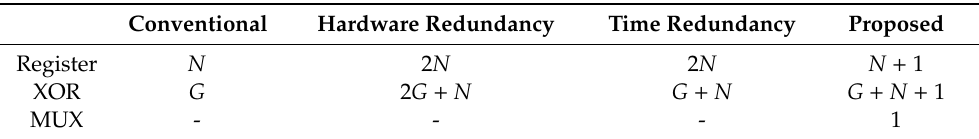
Table 3. Summary of hardware